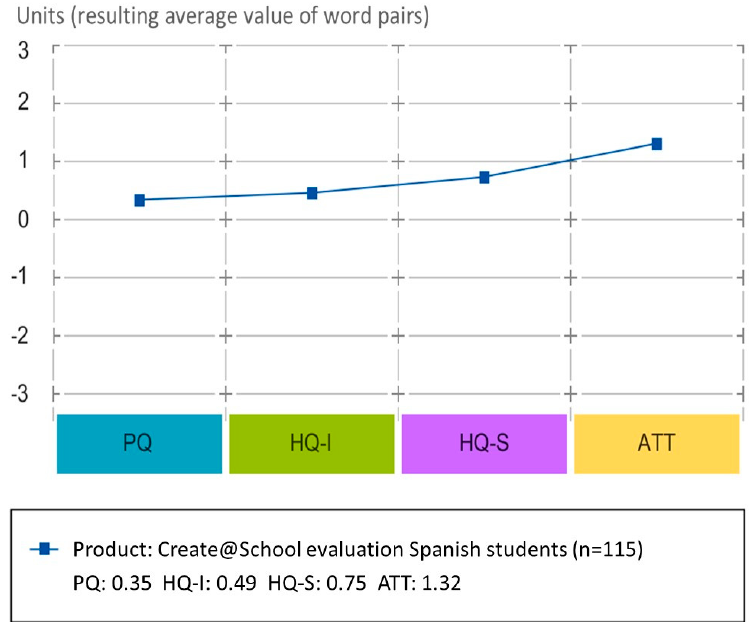
Figure 8. Diagram of the average values for pragmatic qualities (PQs), hedonic identity quality (HQ-I), hedonic stimulation quality (HQ-S), and attractiveness (ATT) for the study 3.2.3.